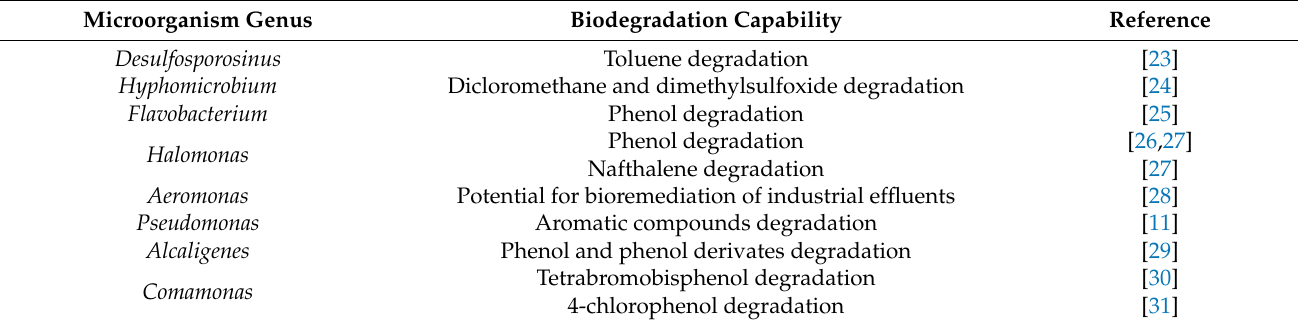
Table 2. Bacterial genera and biodegradation potential for organic compounds, including several bacterial genera detected by massive sequencing analysis in samples from the